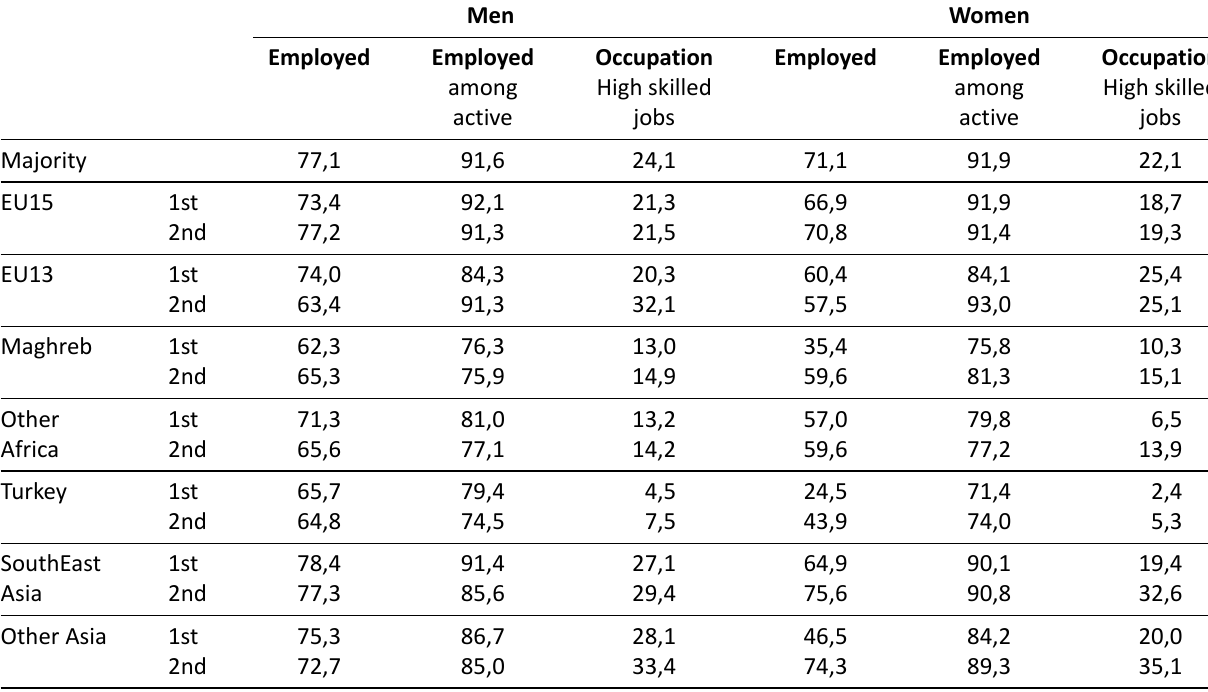
Table 1. Labour market outcomes by country of origin, generation and by gender (in %). Source: INSEE Labour Force Survey 2013–2017, excluding people in education or in